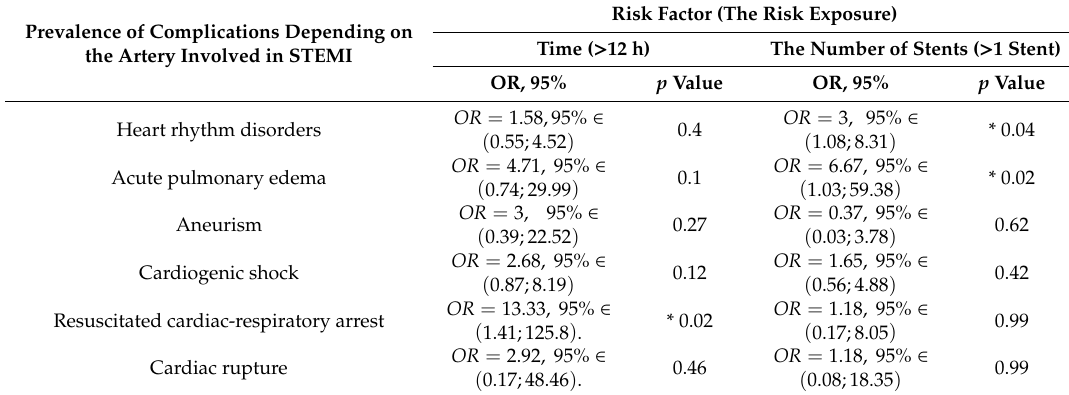
Table 4. The risk factors in two different scenarios (1st scenario—time as a risk factor; 2nd scenario— the number of stents as a risk factor), for all the tested complications in the NRP+ group. Prevalence of Complications Depending on the Artery Involved in STEMI